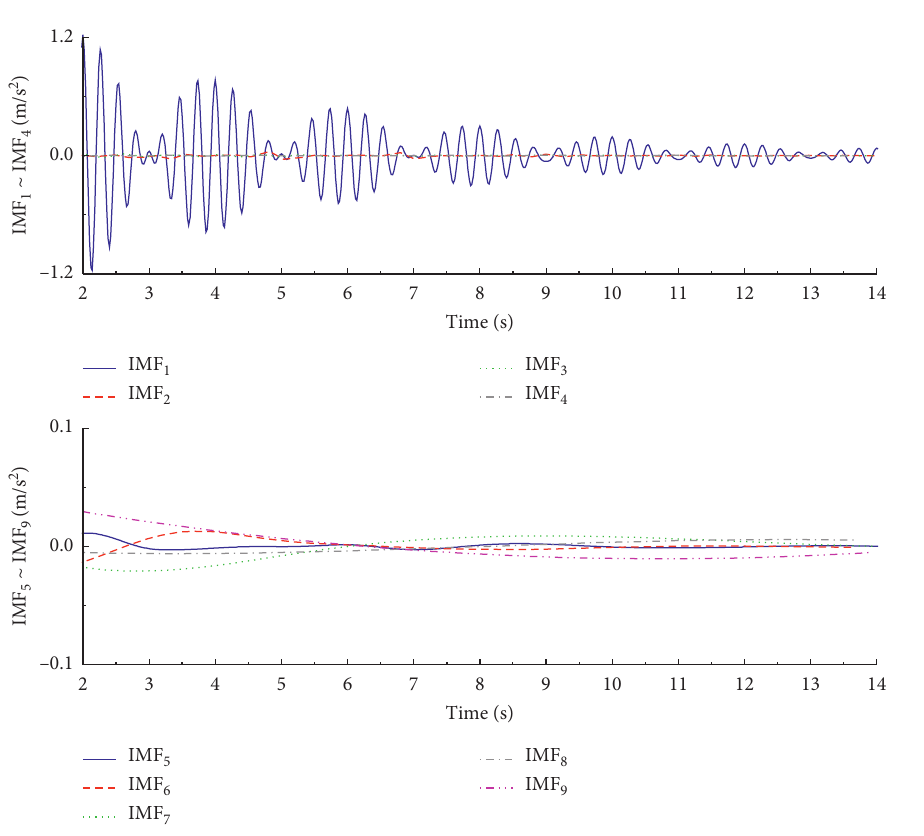
Figure 3: Empirical model decomposition results with closely spaced